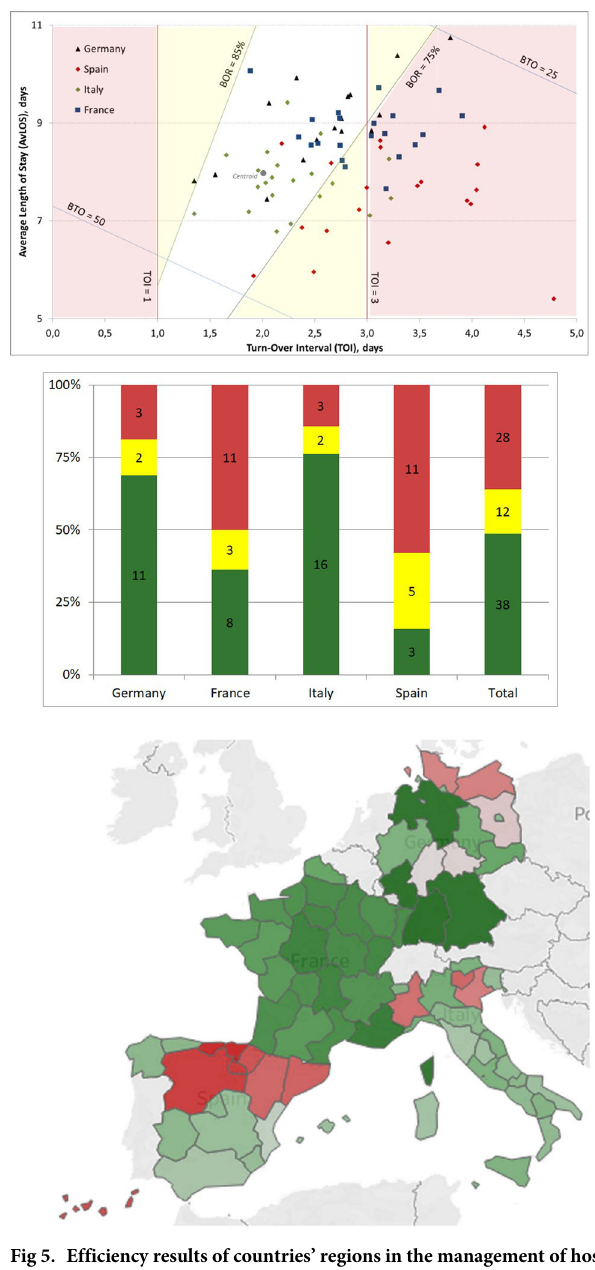
Fig 5. Efficiency results of countries’ regions in the management of hospital beds: (a) Barber-Johnson diagram highlighting the three areas and the centroid (TOI = 2 and BOR = 80%); (b) distribution of regions by country and by area and (c) map of the regions. Each region is coloured on the basis of the Euclidean distance from the centroid: dark red reported the highest distance, dark green reported the lowest distance (map was created on the basis of Eurostat data [23] using Tableau Software; Seattle, Washington, United